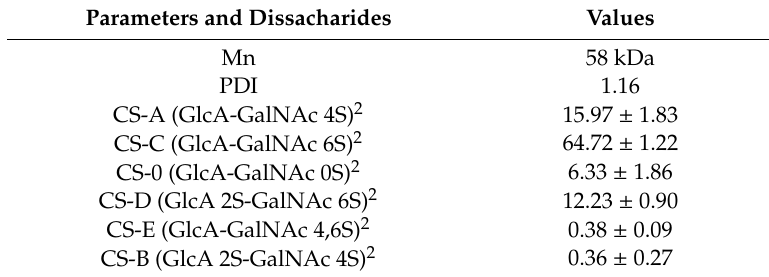
Table 3. Molecular weight and disaccharide composition of CS from P. glauca . M n : number average molecular weight, PDI: polydispersity index ( M w / M n ); Disaccharide composition expressed as mean % ± standard deviation (n =